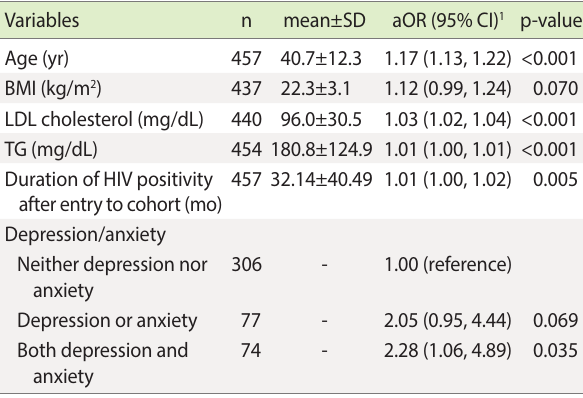
CVD, cardiovascular disease; SD, standard deviation; aOR, adjusted odds ratio; CI, confidence interval; BMI, body mass index; LDL, low-den- sity lipoprotein; TG, triglycerides; HIV, human immunodeficiency virus. 1 Adjusted for age, BMI, LDL cholesterol, TG, duration of HIV positivity after entry into the cohort, and